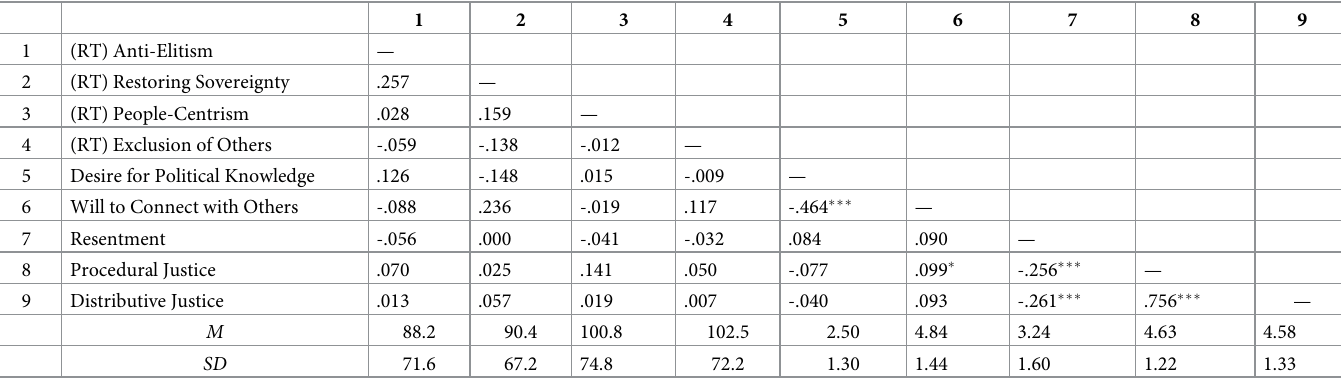
Table 1. Zero-order correlations between predictors of selective exposure to populist